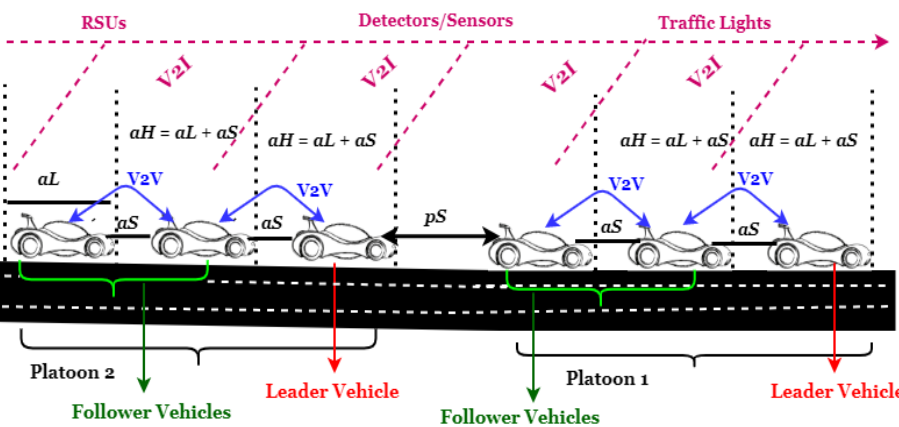
Figure 2. Platooning of vehicles with leader and follower vehicles using Vehicle-to-Vehicle (V2V) and Vehicle-to-Infrastructure (V2I)